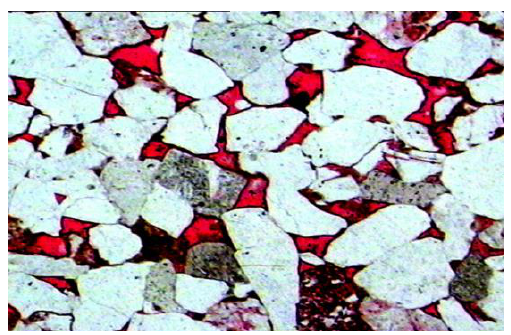
Figure 1. Sandstone slice under scanning electron microscope (single polarized ×